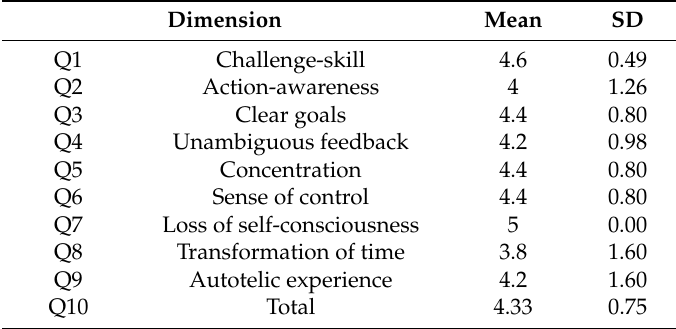
Table 3. Short flow state scale single dimension mean score.